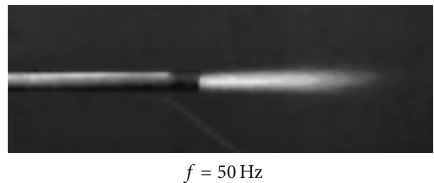
Figure 3: Typical photo of operation of pulsed detonation tube of LIH SB RAS with frequency 50 Hz.